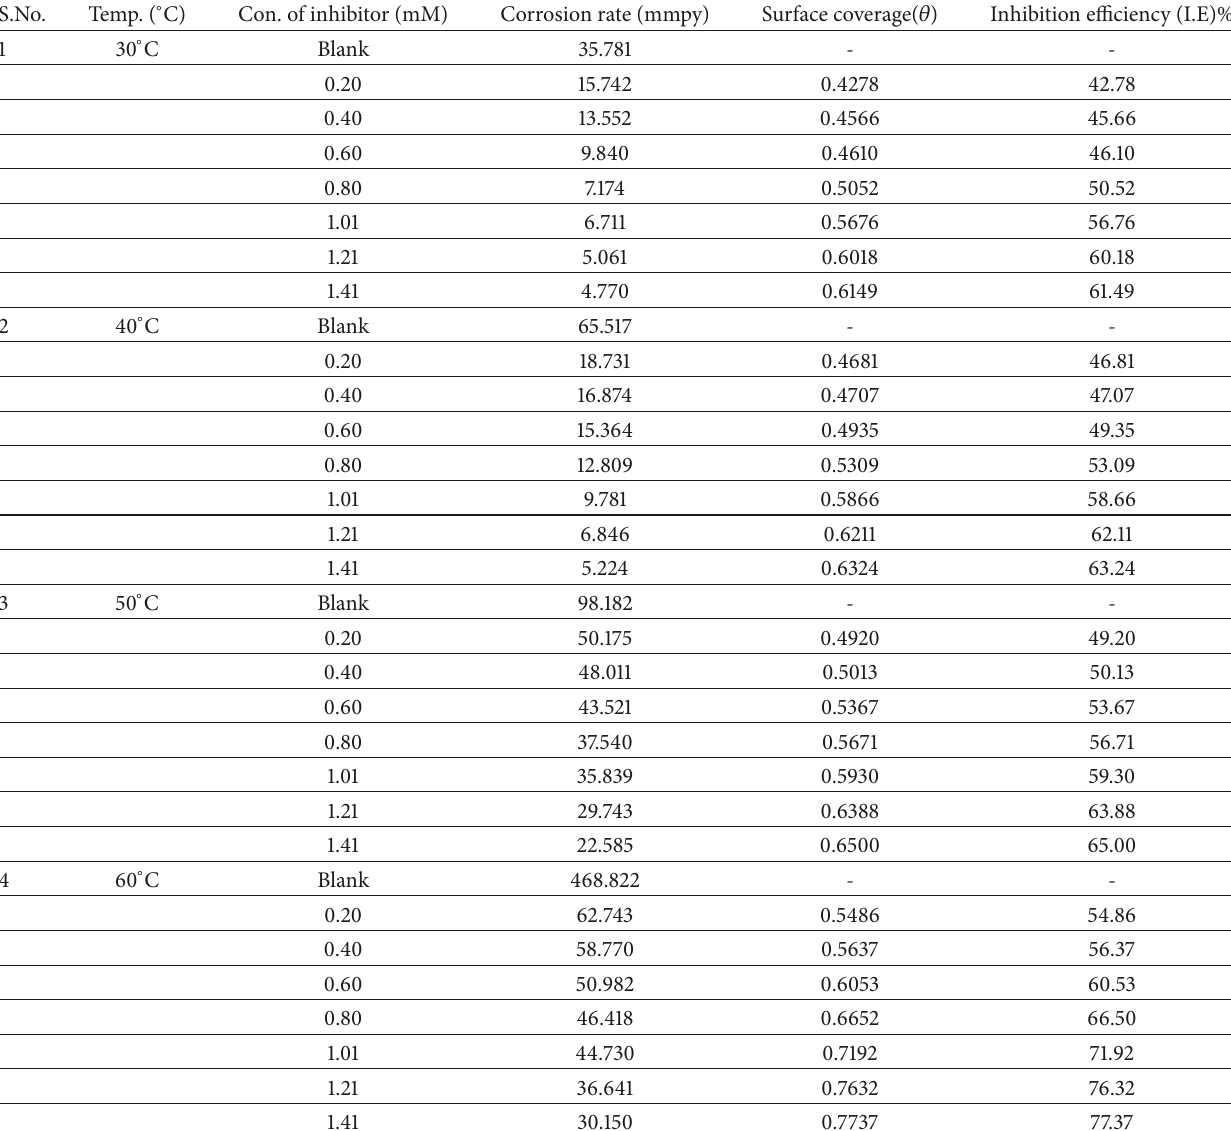
Table 1: Weight loss measurements of brass in IM HCl with BFC from 30 ∘ C to 60 ∘ C.